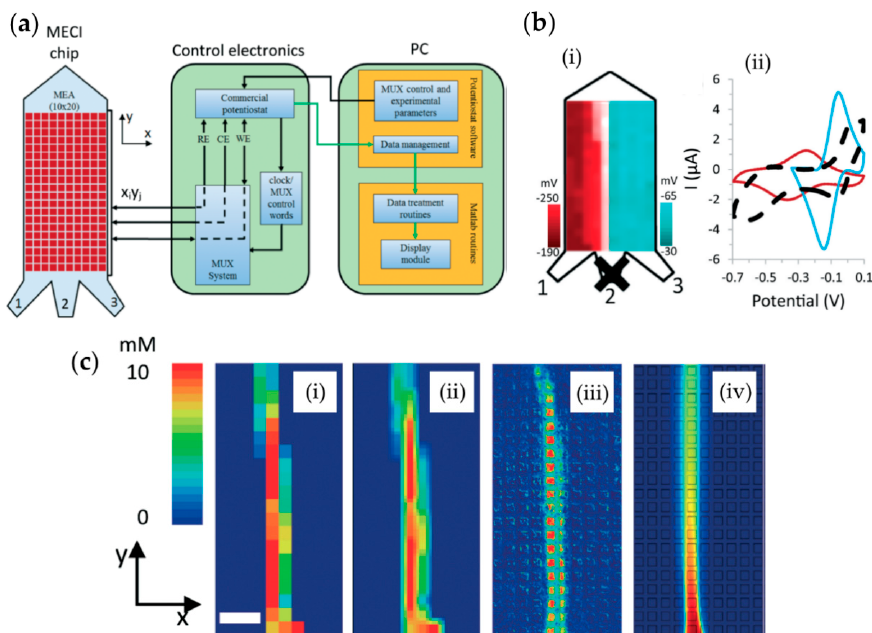
Figure 10. Electrochemical imaging for microfluidics on a microfluidic electrochemical imaging (MECI) chip. ( a ) Schematic of microfluidic device housing a MEA, where RE is the reference electrode, CE is the counter electrode, WE is the working electrode, and MUX is a low-noise multiplexer. ( b ) (i) Electrochemical image of a co-flow of Ru(NH 3 ) 63+ (red) and Fe(CN) 63 − (blue) at inlet 1 and 3, respectively. (ii) Representative CVs for Ru(NH 3 ) 63+ (red), Fe(CN) 63 − (blue), and the overlapping region (black dashed), without baseline correction. ( c ) Electrochemical image of 10 mM Fe(CN) 63 − stream from inlet 2, with confinement streams from inlets 1 and 3. (i) Raw data, (ii) after smoothing algorithm applied (iii) optical image with dye added to the analyte and (iv) computer simulation. Scale bar is 1 mm. (Adapted from Reference [137] with permission of The Royal Society of Chemistry). Using 64 subarrays of 128 individual Pt working electrodes, high-density MEAs of 8192